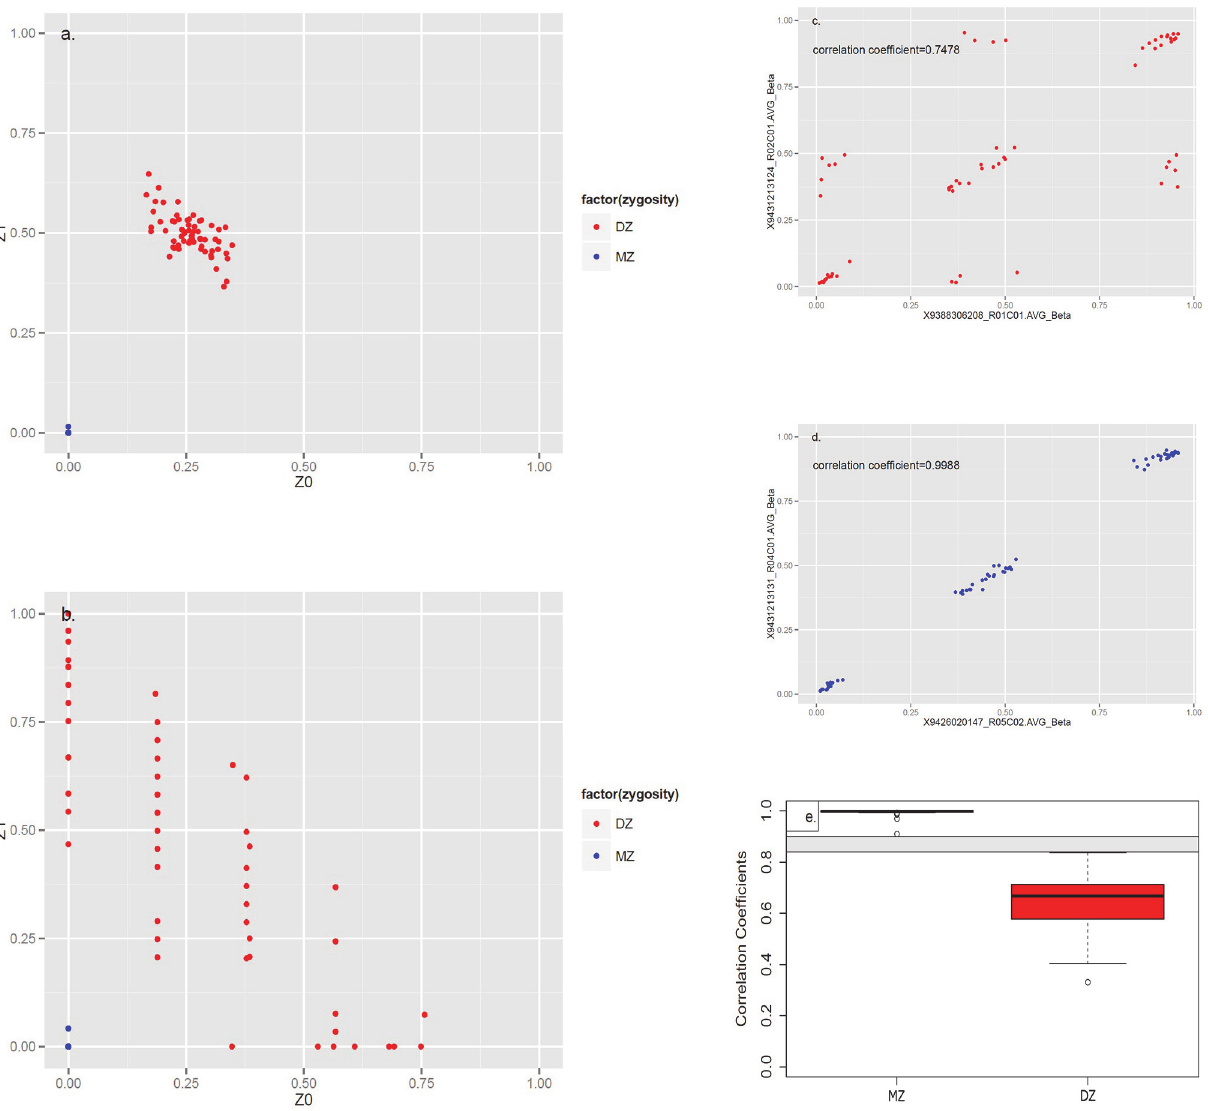
Fig 2. Relatedness Analysis of Discriminating Monozygotic\Dizygotic Twin Pairs by Genotyping and Methylation Array. (a) was the plot based on Genotyping Array Data, (b) was the plot based on Methylation Array Data. Z 0 , Z 1 referred to identity-by-descent (IBD) probabilities: those for the individuals having zero or one pairs of IBD alleles. The Blue Dots indicated Monozygotic Twins (MZ), which Both Z 0 and Z 1 Approximately equaled to 0, while the Red Dots indicated Dizygotic Twins (DZ), which Z 0 was close to 0.25 and Z 1 was close to 0.5 by Genotyping Array Data. (c) was an scatter plot of methylation 65 SNPs beta values in a representative DZ pair with calculating the intra pair correlation coefficient 0.7478, (d) was an example of MZ pair with correlation coefficient 0.9988, (e) was the boxplot of methylation 65 SNPs correlation coefficient for MZ versus DZ, the grey area indicated possible cut-off points (correlation coefficient ranged 0.84 – 0.90) for discriminating MZ and DZ